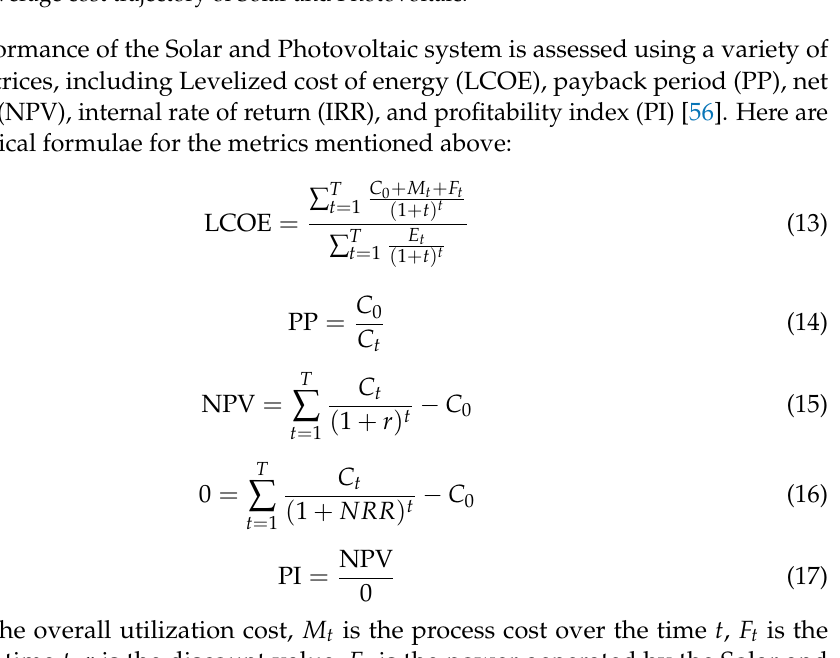
Figure 5. The average cost trajectory of Solar and